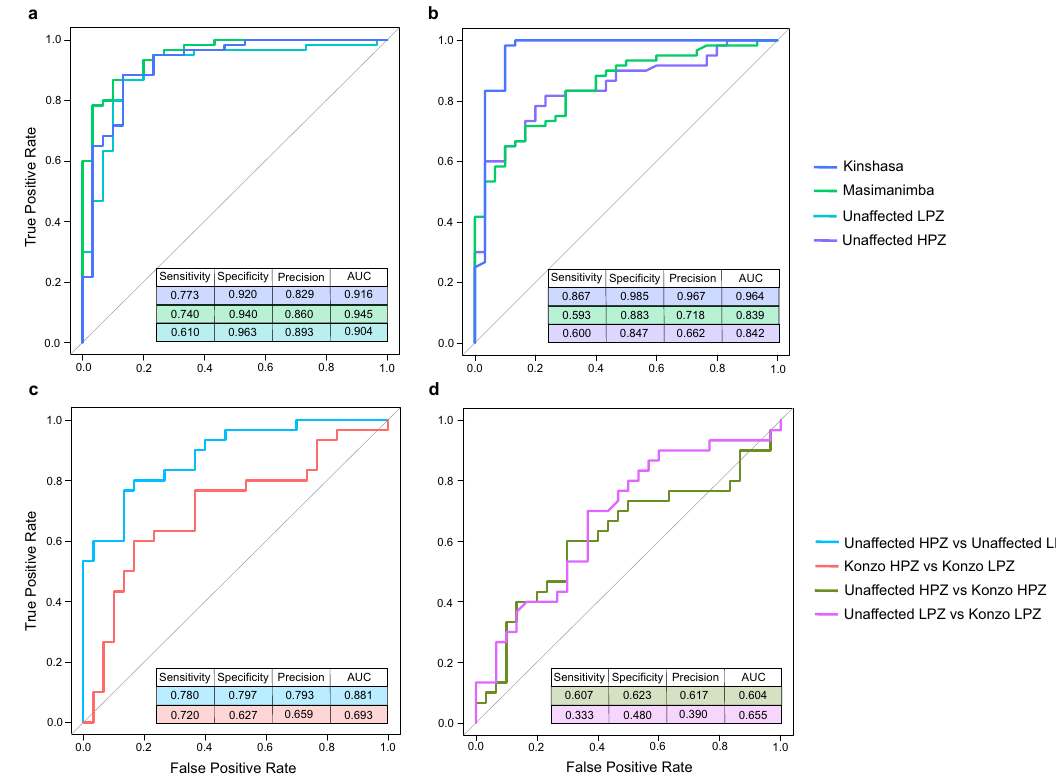
Fig. 4 Random forest classi fi cation across populations. Receiver operating characteristic (ROC) curves and classi fi cation performance metrics for one-vs- all random forest classi fi ers for a Kinshasa vs Masi-manimba vs Kahemba unaffected low prevalence zone (LPZ), and b Kinshasa vs Masi-manimba vs Kahemba unaffected high prevalence zone (HPZ), binary classi fi er for c unaffected individuals from HPZ vs unaffected individuals from LPZ, and those with konzo from HPZ vs konzo from LPZ, and d konzo vs unaffected individuals from LPZ and HPZ. All ROC curves and performance metrics are averaged over 10 repetitions of 10-fold